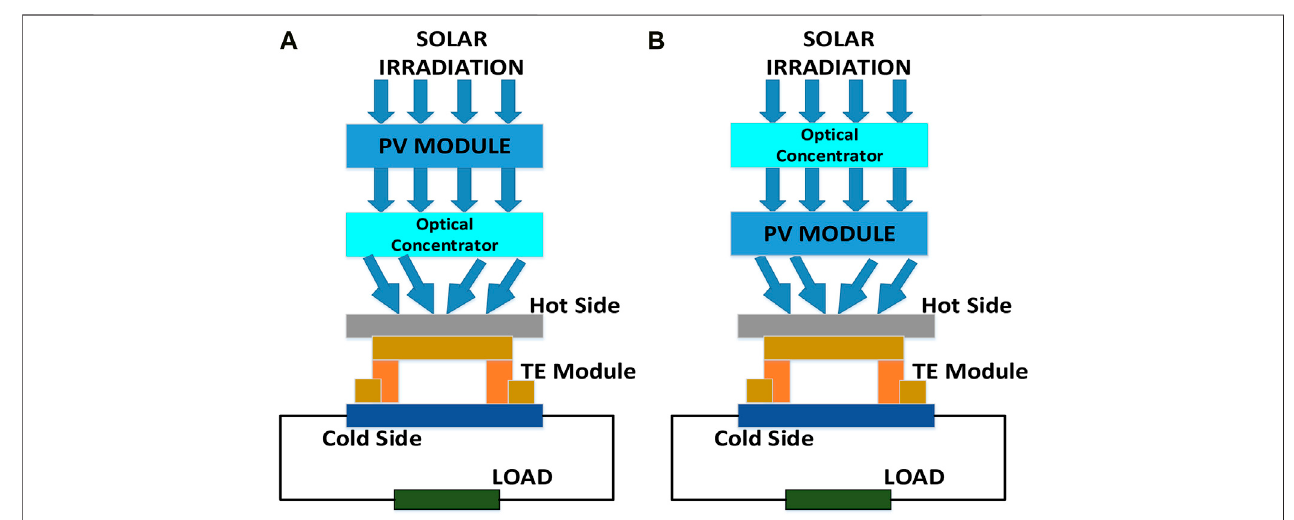
FIGURE 11 | PV – TEG with (A) Direct and (B) Indirect coupling (optical concentrator).